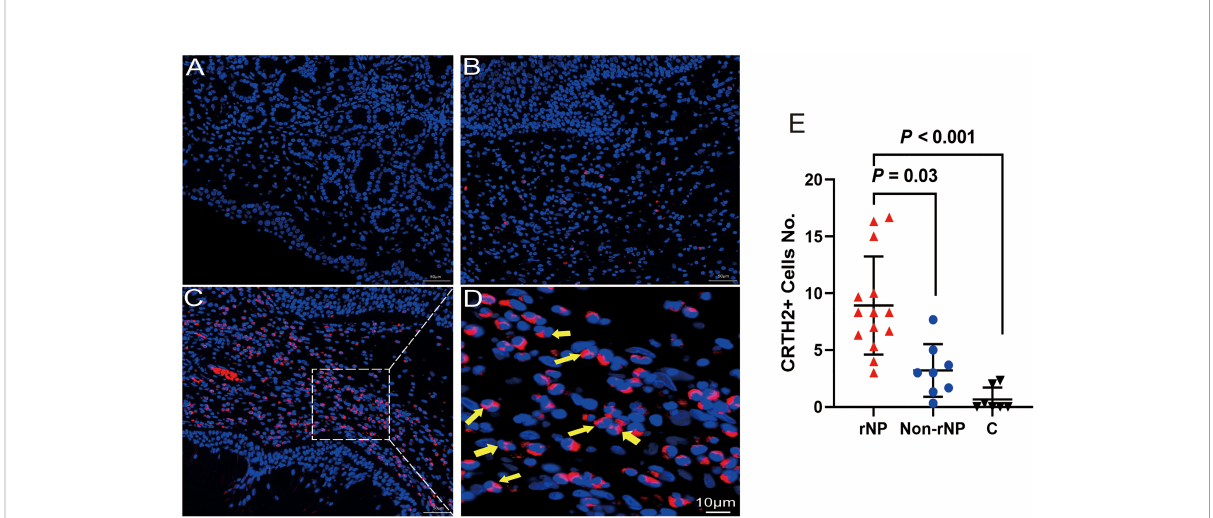
FIGURE 2 Immuno fl uorescence for CRTH2 (red color) in polyps from patients with NP and control tissue. (A) Control tissue. (B) Non-rNP tissue. (C) Tissue from a patient with rNP. (D) A close-up view of picture (C) , yellow arrows indicate eosinophils with bilobed nuclei. A dot plot showing positive CRTH2 cells/hpf for tissue samples from patients with rNP (n = 14) / Non-rNP (n = 8) / control subjects (n = 7) (E) . Images were generated as described in methods and analyzed by counting CRTH2+ cells with the exclusion of epithelial and glandular cells. C, control